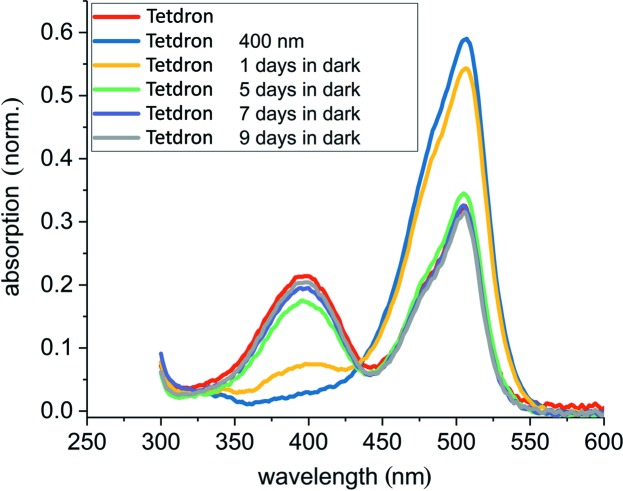
Solution UV–vis spectra of Tetdron before (red) and after (blue) irradiation with 400 nm light, followed by relaxation and re-protonation of the chromophore in the dark (yellow to grey lines).